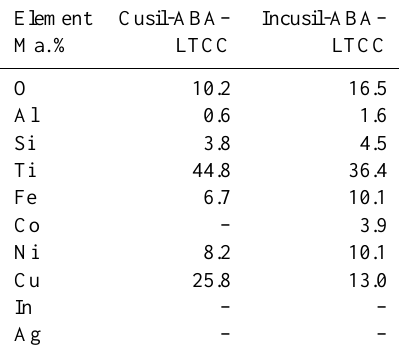
Table 4. Compositions of interfacial reaction layers Cusil-ABA– LTCC and Cusil-ABA–Al 2 O 3 after brazing at 850 ◦ C for